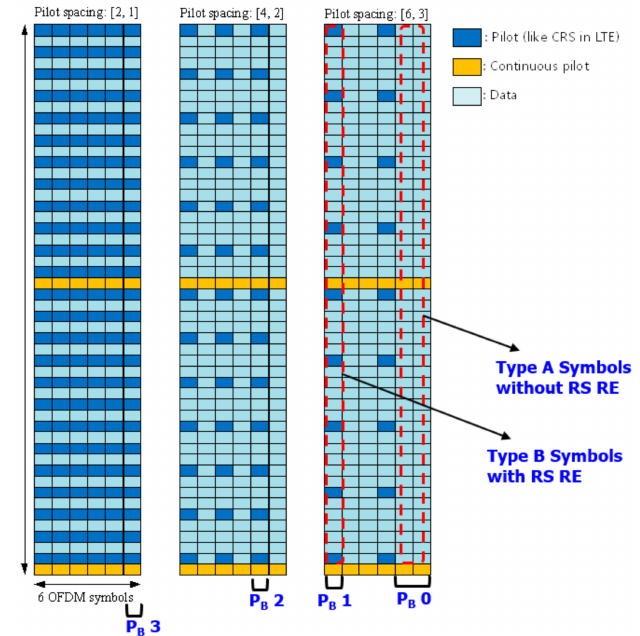
Figure 5. Power o ff sets based on pilot spacing [6, 3], [4, 2], and [2,